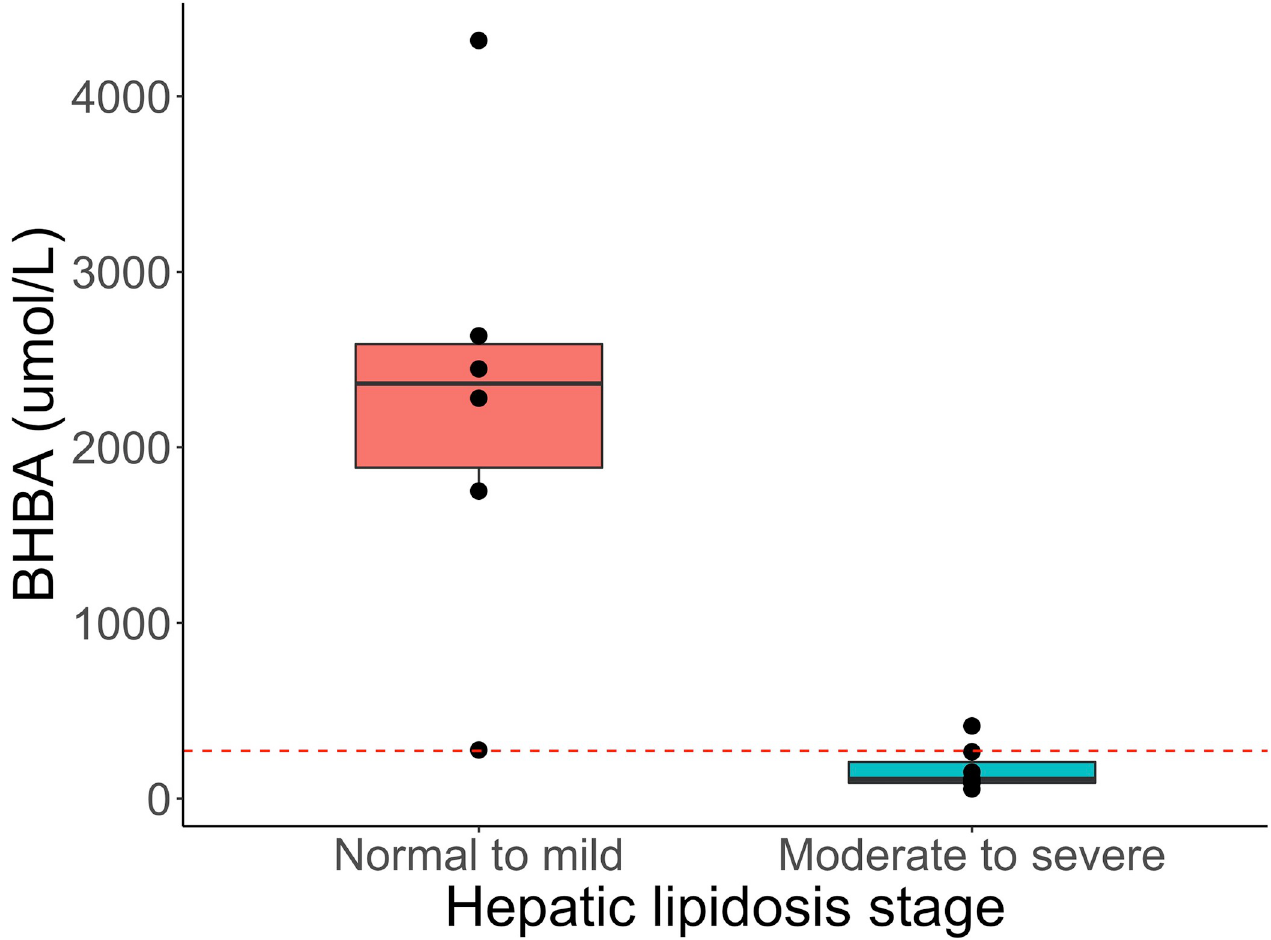
Fig 4. Box plot with superimposed dot plot of hepatic to fat pad echogenicity ratio on ultrasound across two simplified classes of hepatic lipid changes (no-lipid to mild and moderate to severe) based on an established grading system in bearded dragons [30] evaluated by a t-test.